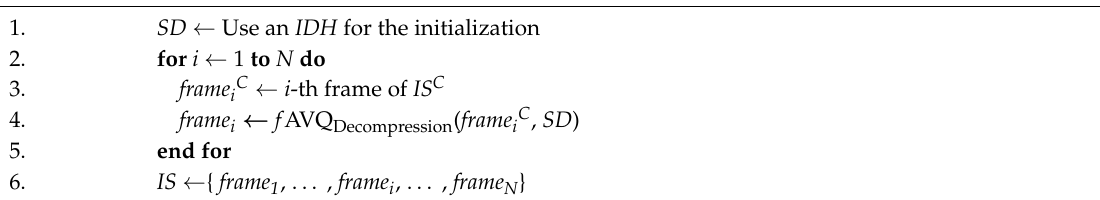
Algorithm 4. Pseudo-code of the decompression stage (AVQ IS algorithm).